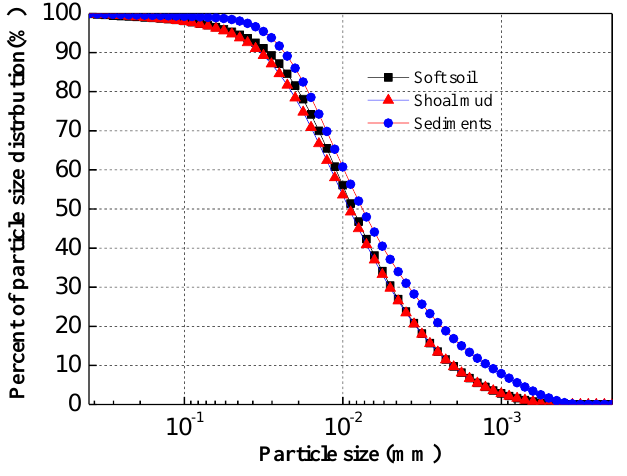
Figure 1. Size distribution of river sediment.